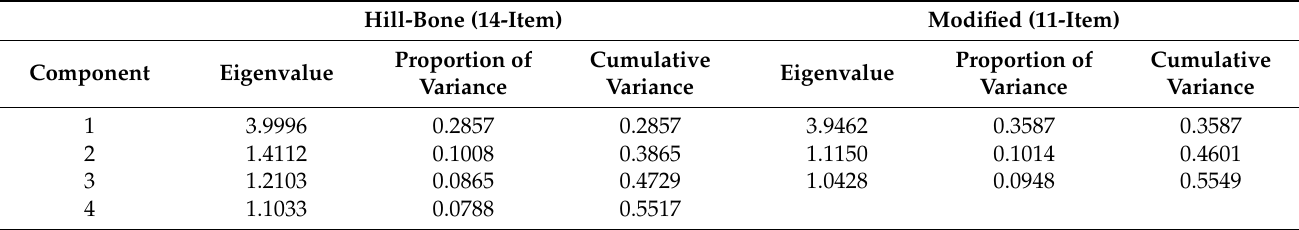
Table A2. Principal Component Analysis for construct